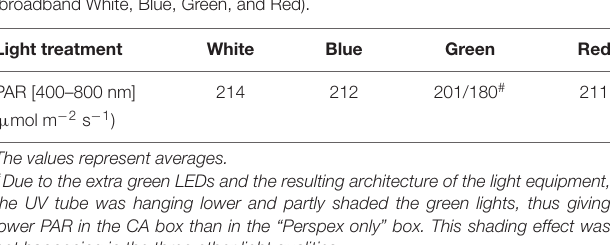
TABLE 1 | Photosynthetically active radiation of four different light backgrounds (broadband White, Blue, Green, and Red). Light treatment White Blue Green Red PAR [400–800 nm]